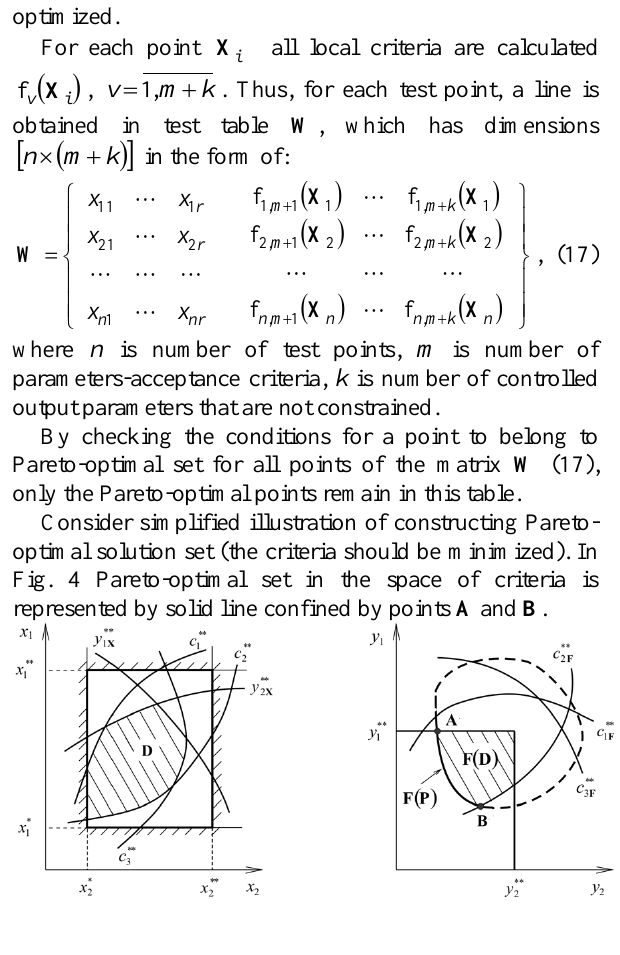
Fig. 4. The Pareto set   PF obtained with functional and criterial